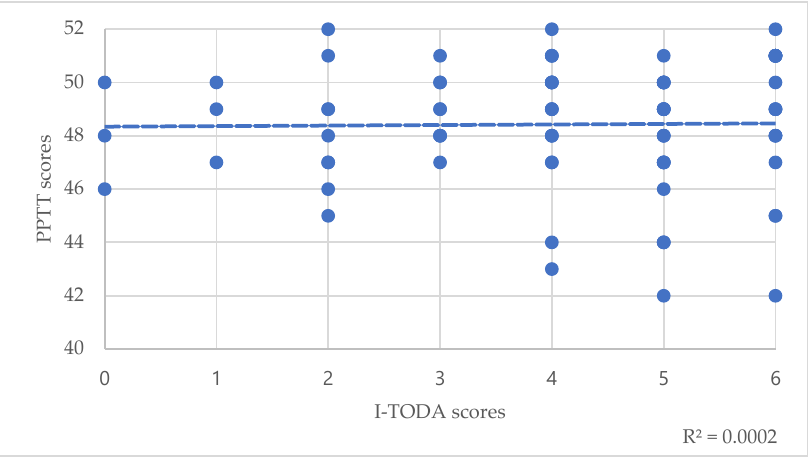
R² = 0.0002 Figure 2. Correlations between PPTT scores and I-TODA scores. The dotted line represents the trend line. Correlations between PPTT scores and the four SST scores were not statistically signifi- cant regarding the total population (Table 3). However, the trend line regarding correlation between PPTT scores and I-SST scores revealed that the lower the I-SST score, the lower the PPTT score (Figure 3).